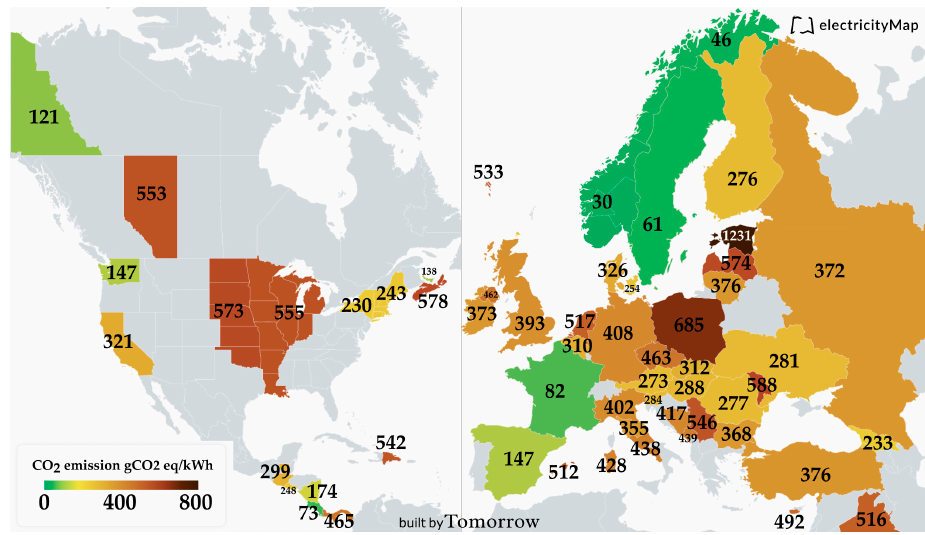
Figure 29. Electricity emissions intensity grams CO 2 e per kWh (g/CO 2 eq/kWh) snapshot from electricity. Map taken at 01.02.2019 12:00 UTC [65].